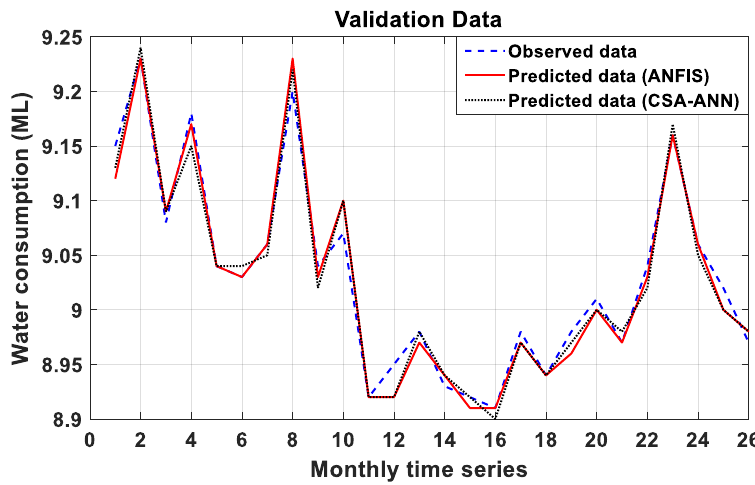
Figure 7. Observed and predicted water time series comparison for the ANFIS and CSA-ANN models